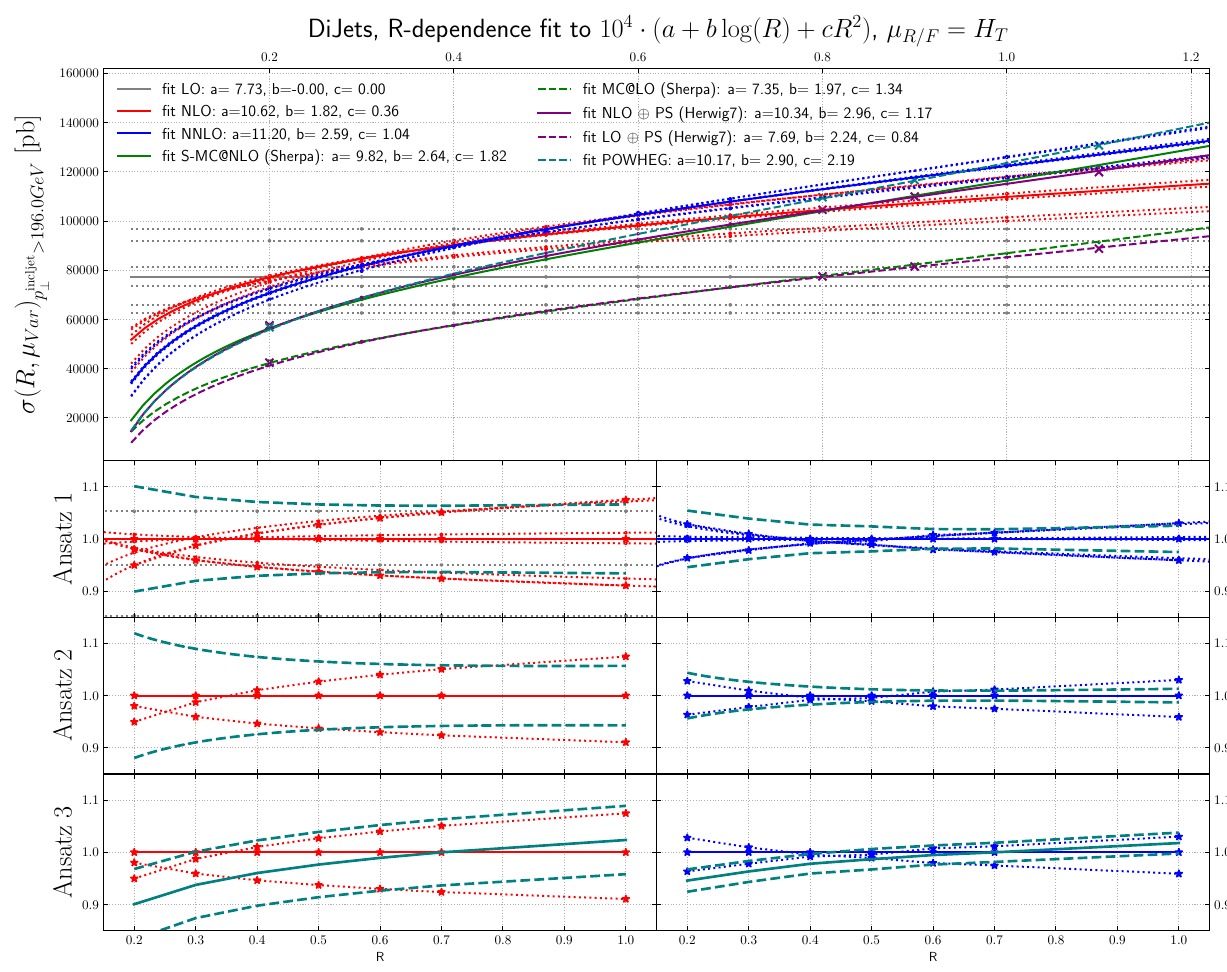
Fig. 9 The R -dependence of the cross sections for inclusive jet production at LO, NLO, NNLO and NLO+PS are shown, for scale variations around a central scale of H T , as a function of jet radius, for dijet production, for leading jet transverse momenta above 196 GeV